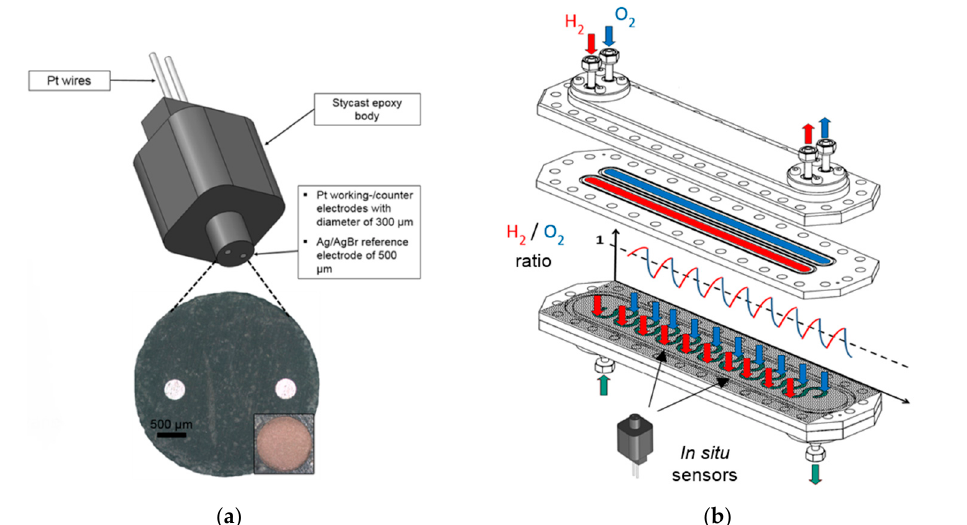
Figure 1. ( a ) Schematic depiction and photograph of the electrode plug design used in the reactor, including Pt microelectrodes and Ag/AgBr reference electrode (inset); ( b ) Schematic of the membrane micro reactor with electrochemical in situ sensors in the microchannel.